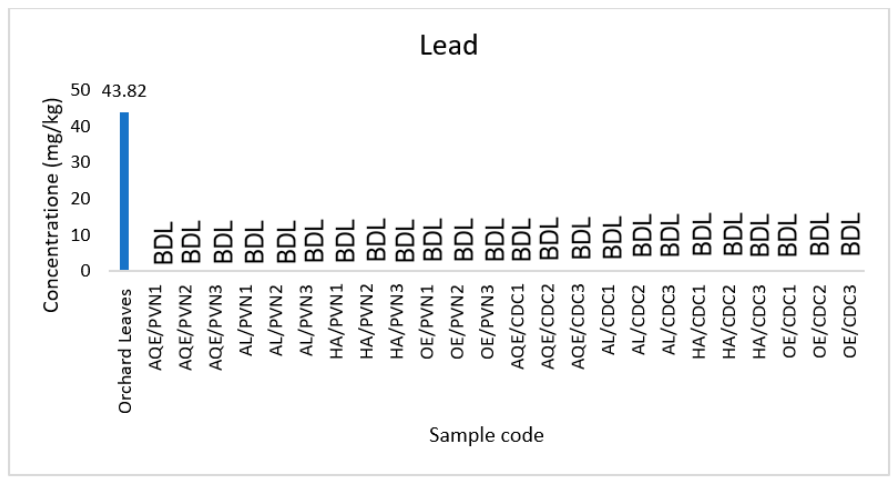
Figure 7. The graph shows Pb concentrations (mg/kg) in extract samples with standard reference material NIST 1571 Orchard leaves.